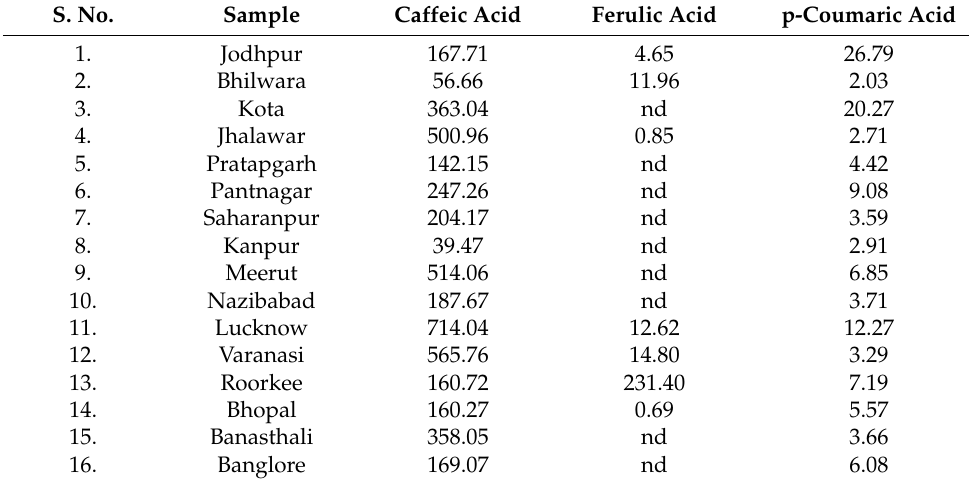
Table 10. The concentration (mg/100 g.dw − 1 ) of phenolic acids (caffeic acid, ferulic acid, and p-coumaric acid) in S. cumini